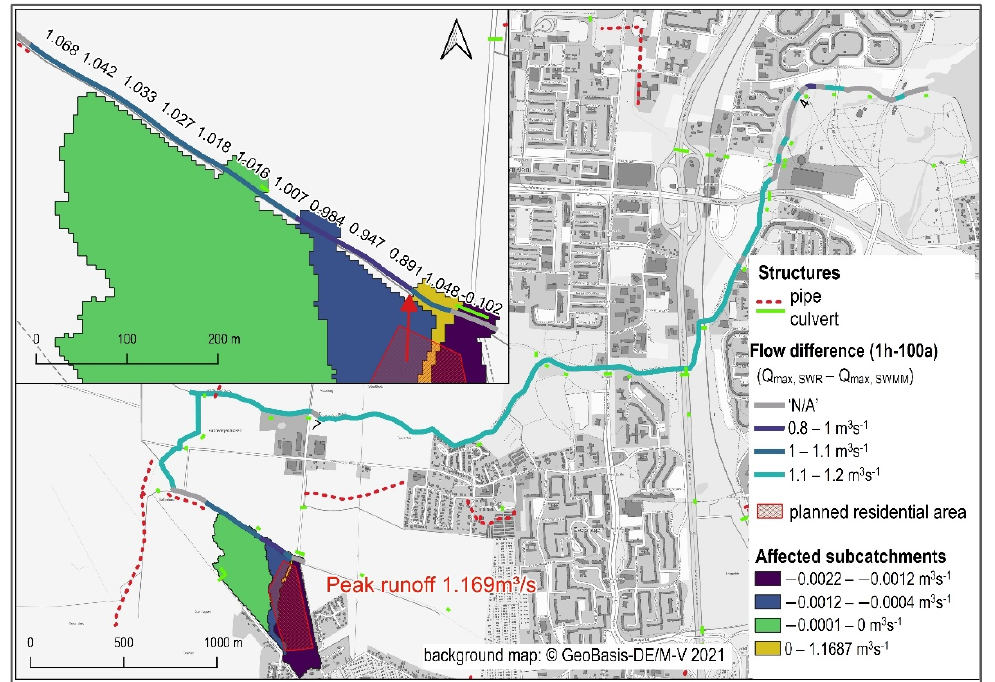
Figure 13. Peak runoff generated on the affected subcatchments and flow difference in m 3 s − 1 (Q max,SWR − Q max, SWMM ) in plan state for the rain event 1h-100a.